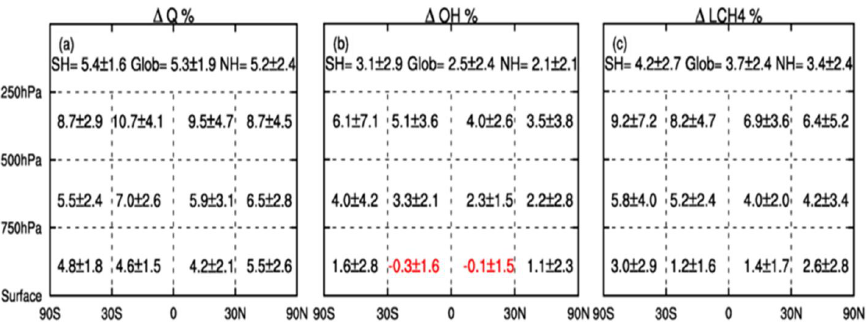
Figure 7. Percent change in multi-model mean OH in 12 subdomains of the atmosphere for Fig. 6. Percent change in multi-model mean (10 models) regional a) specific humidity, b) tropospheric OH and c) methane loss flux due to 2000 relative to attribution experiments: a) Em2000CH41850 (8 models), b) Em2000CO1850 (6 climate change only (2000–Em2000Cl1850). Decreases are shown in red and increases are in black. models), c) Em2000NOx1850 (6 models), d) Em2000NMVOC1850 (6 models). OH increases are shown in black and decreases are in red.